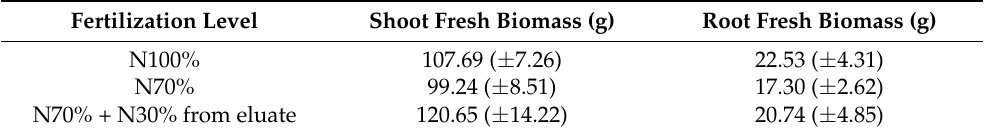
Figure 2. Effect of the eluate on tomato production. Ripe fruits (dark grey and mid grey) were harvested twice, while unripe fruits (light grey) were harvested at the end of the trial, at the second harvest. The reduction in N (N70%) caused an anticipation of fruit ripening ( left box, 1 ◦ harvest) and an increase in the yield ( right box, 1 ◦ harvest). Conversely, the addition of the eluate to reach full nutrition delayed both parameters, but it caused a significant increase in the total fruit number and a high rise in the total yield, also compared with N100%. Thin black bars indicate the 95% confidence interval. The total production is shown above the bars. Bars labeled with different letters differ significantly ( p < 0.05, Duncan test).